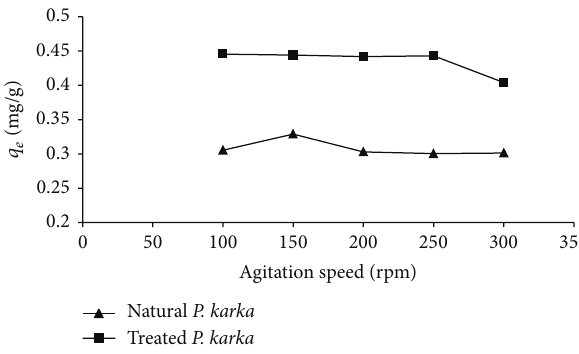
Figure 4: Effect of agitation speed on adsorption capacity of natural P. karka and treated P. karka (concentration = 10mg/L, time = 30 minutes, 𝑇 = 298 K, agitation speed = 100–300 rpm, dose of biosorbent = 2g/100 mL, and pH = 6 and 7 for natural P. karka and treated p. karka ,